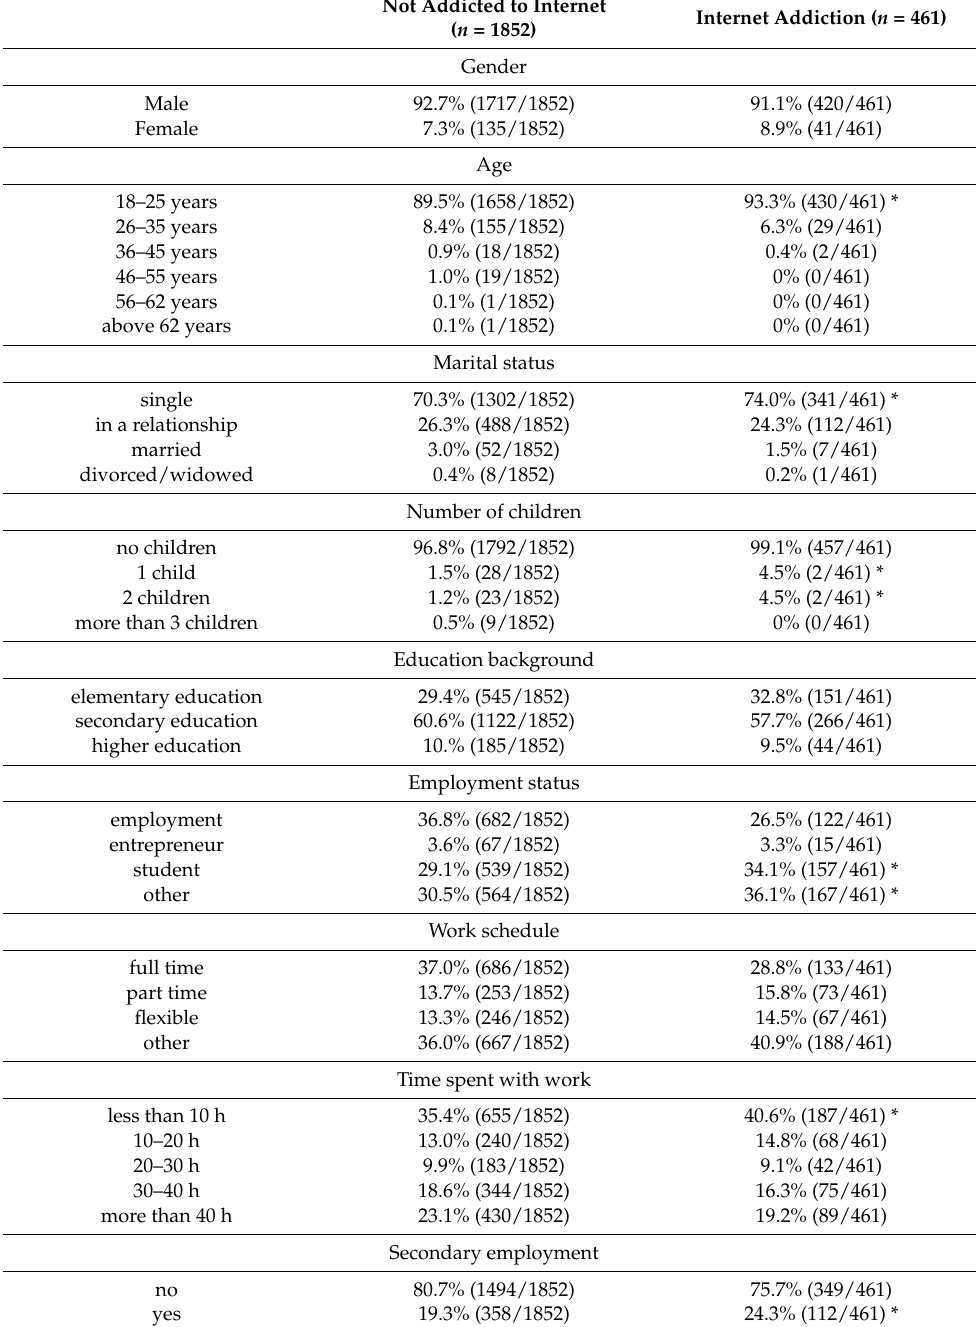
Table 3. Comparison of baseline characteristics of the study subgroups (* p <